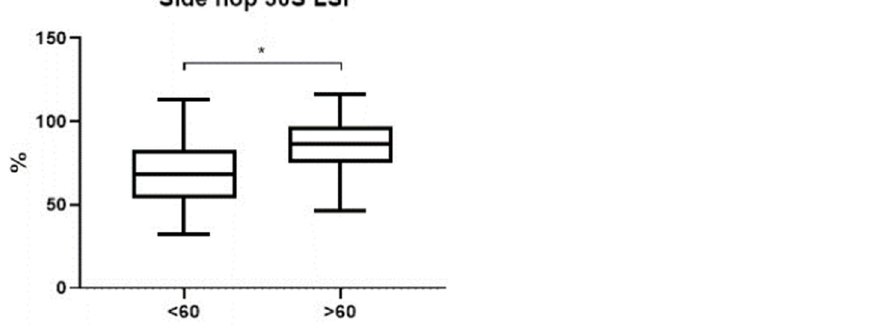
Figure 7. Box-plots showing differences between the two groups with the same change compared to the baseline for the various parameters. The black line inside the box represents median value. The lowest bar represents the 10th percentile, the bottom and top of the boxes represent the interquartile range (25th and 75th percentiles), and the top bar represents the 90th percentile. * p < 0.05.